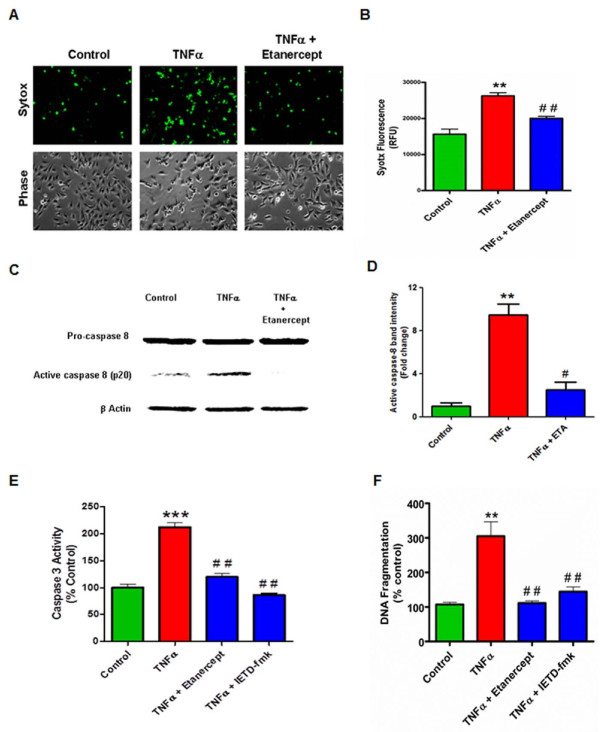
Tumor necrosis factor (TNF)-induced neurotoxicity and caspase activation in N27 dopaminergic neuronal cells. (A) Visualization of TNF toxicity by Sytox fluorescence cytotoxicity assay. N27 dopaminergic cells treated with TNF (30 ng/ml), or pretreated with etanercept (5 μg/ml) for 30 minutes and were processed for Sytox green imaging at 16 h. Increased green fluorescence is evident with TNF treatment, indicating significant neurotoxicity which was also evident in the phase contrast images. (B) Sytox fluorescence was quantified by measuring the fluorescence intensity as relative fluorescence units (RFU) using a plate reader. (C) Activation of caspase-8 by TNF treatment. Lysates from N27 cells treated with TNF (30 ng/ml) for 3 h were probed using a rabbit polyclonal antibody to caspase-8 that detects the procaspase and the active cleaved form. TNF induced a significant increase in the active caspase-8 (p20) fragment, which was blocked by pretreatment with etanercept (5 μg/ml). (D) Band intensities for cleaved caspase-8 from three blots were quantified using densitometric analysis and normalized to β-actin. (E) TNF induced activation of caspase-3. Enzymatic assays for caspase-3 activity in lysates from N27 cells treated with TNF (30 ng/ml) for 6 h or pretreated with either etanercept (5 μg/ml) or the caspase-8 inhibitor IETD-fmk (25 μM) for 30 minutes. Raw values were normalized using protein concentrations and expressed as percent control. TNF treatment induced significant activation of caspase-3, which was blocked by etanercept and the caspase-8 inhibitor IETD-fmk. (F) TNF-induced DNA fragmentation. N27 cells were treated with TNF (30 ng/ml) for 16 h or pretreated for 30 minutes with either etanercept (5 μg/ml) or the caspase-8 peptide inhibitor IETD-fmk (25 μM), and processed for the DNA fragmentation assay. Raw values were normalized using protein concentration and expressed as percent control. TNF treatment significantly increased DNA fragmentation, which was attenuated by etanercept or caspase-8 inhibition. Data represent the group mean ± SEM; n = 6 to 8 per group and experiments were repeated three times. ** (P <0.01) indicates significant differences compared to control cells; ## (P <0.01) and # (P <0.05) indicates significant differences compared to TNF-treated cells.